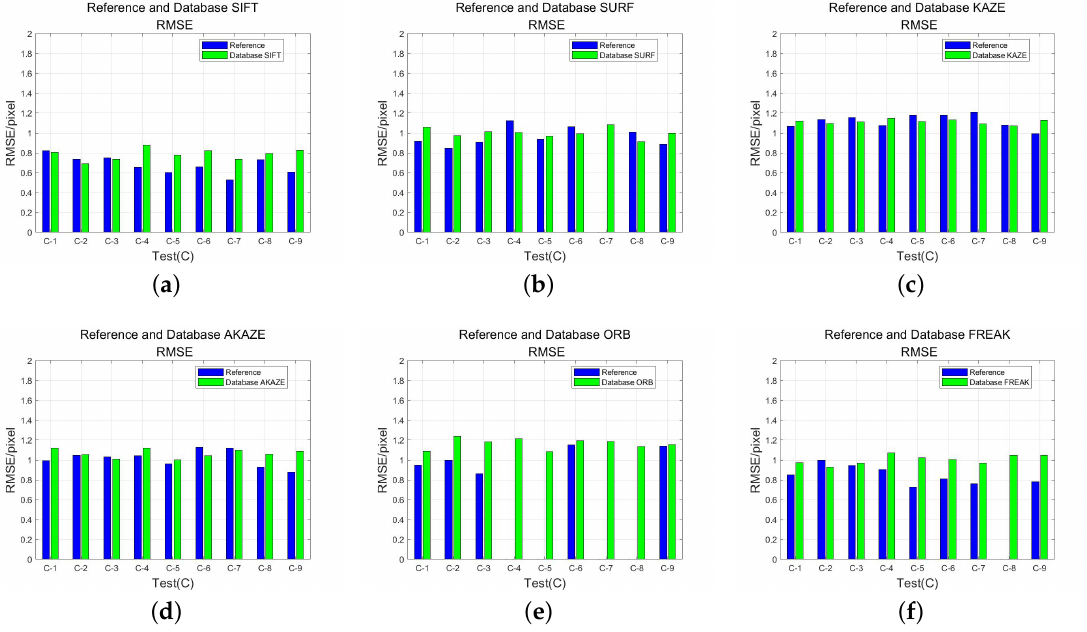
Figure 8. RMSE comparison of direct matching method and feature database matching method.